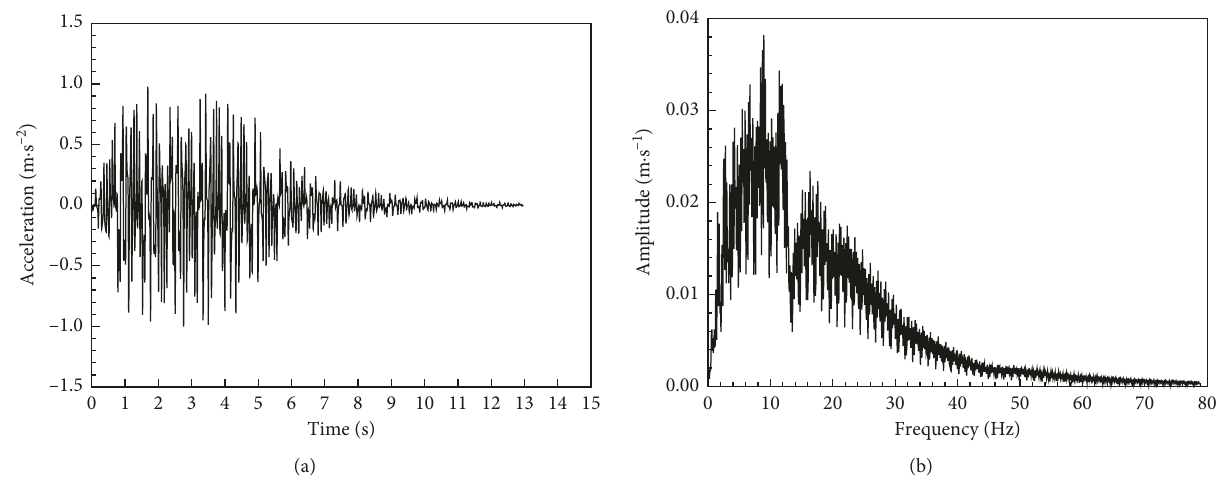
Figure 2: (a) The time history curve of acceleration of the Darui artificial wave and (b) its Fourier spectrum.